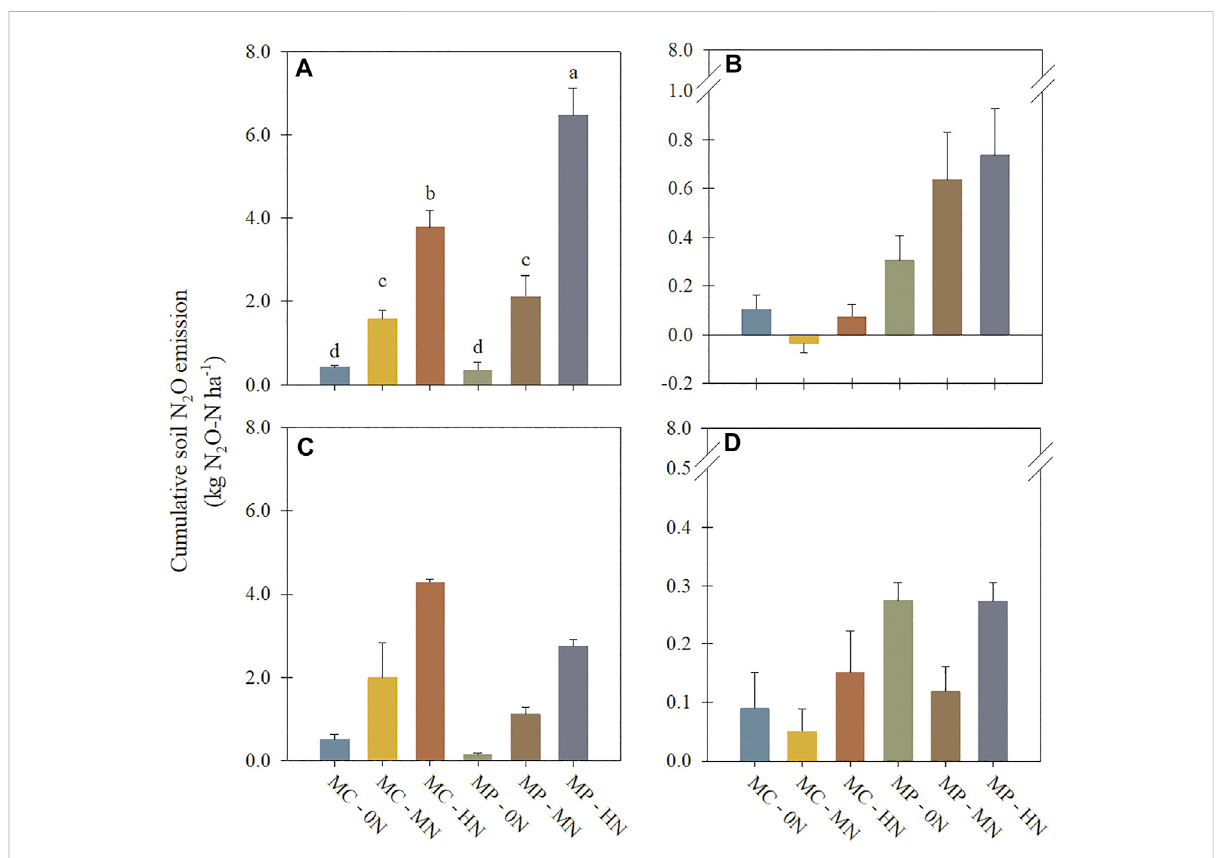
FIGURE 4 Cumulative soil N 2 O emissions for (A) 2019 maize growing season, (B) 2019 pea/fallow season, (C) 2020 maize growing season, (D) 2020 pea/ fallow season as affected by maize monoculture (MC) and pea-maize rotation (MP) and by soil N application rate: 0N (unfertilized), MN (medium N application rate), HN (High N application rate). Different letters are signi fi cantly different according to Tukey test at p = 0.05. Error bars represent standard error.